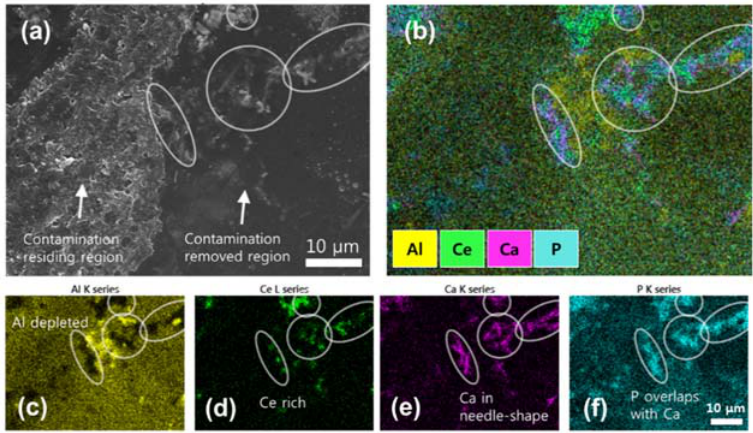
Figure 7. The surface of SiC 0.03 wt %-added enamel coating after the washability test. ( a ) FESEM image and ( b ) image overlaid with Al, Ce, Ca, and P. ( c - f ) elemental map of each element (Al, Ce, Ca, and P).